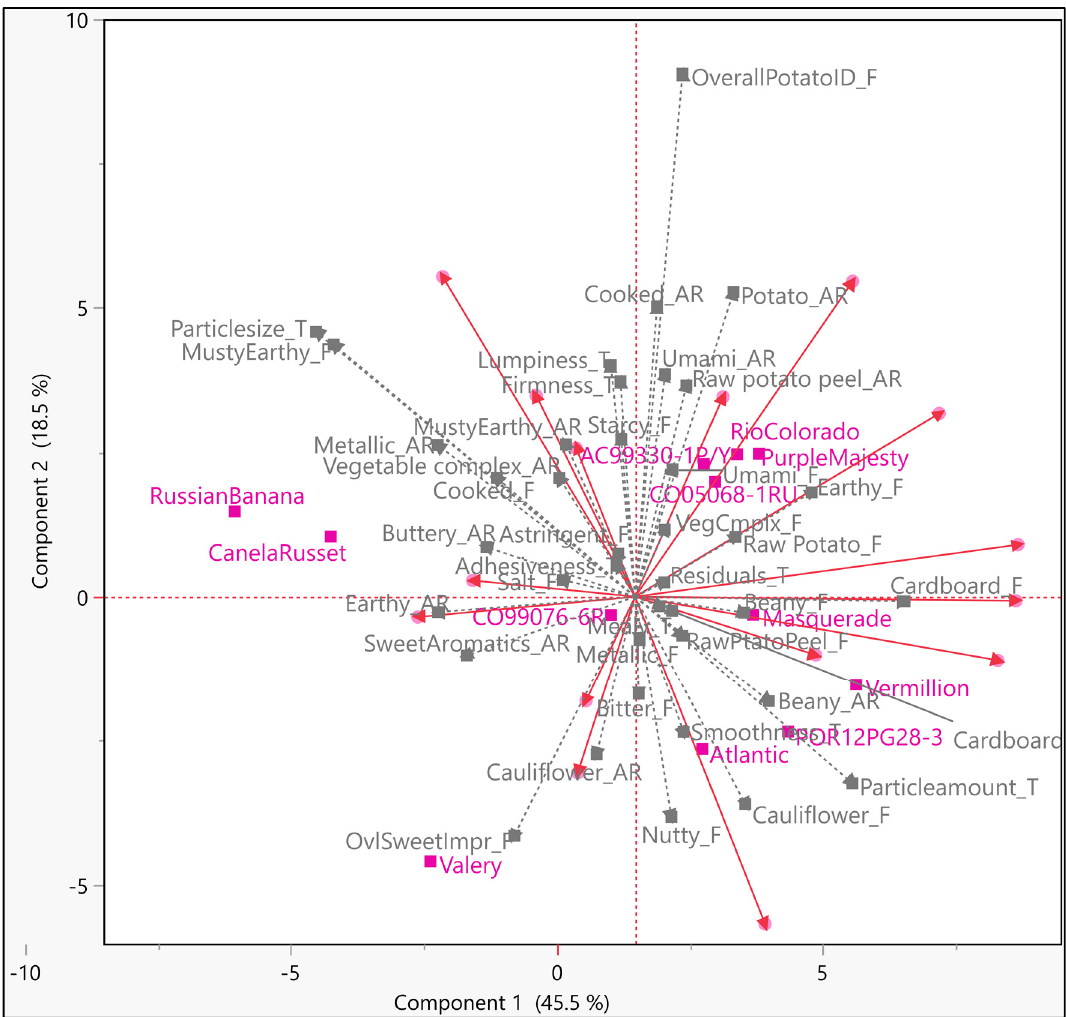
Figure 4. Internal Preference Mapping (IPM) plot for the second segment of respondents ( N = 15); Magenta colored markers ■ and labels—samples; gray colored markers ▲ and labels—sensory descriptors; red colored markers ● and vectors—participants/consumers.